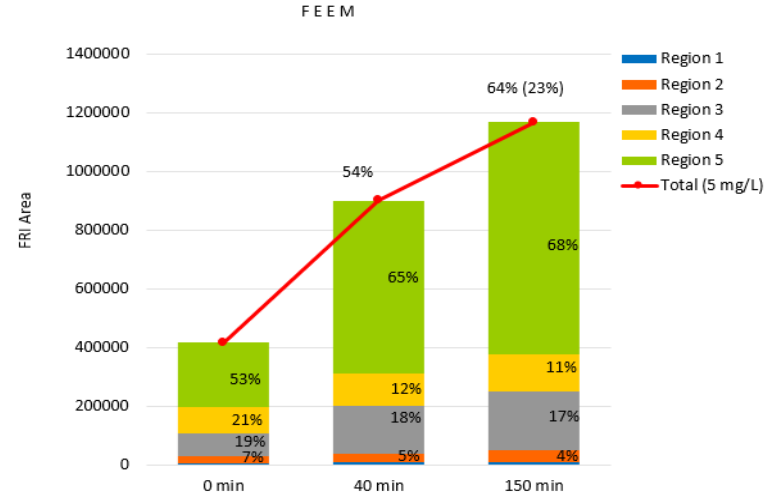
Fig. 5: Variations of average FRI values and percentages for different organic fraction distribution during bionet